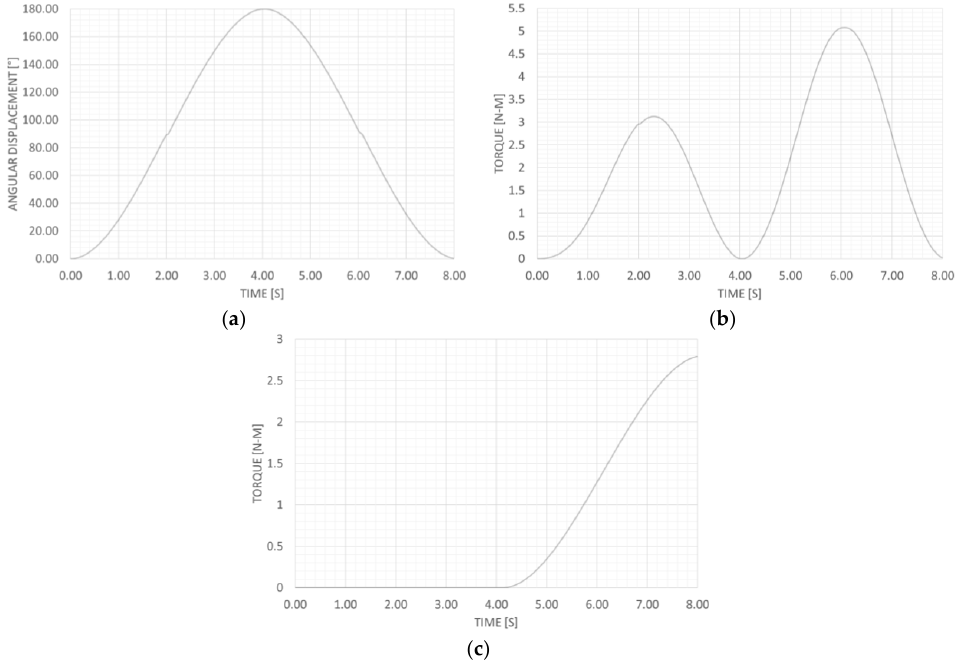
Figure 10. Simulation results for the Motor Unit simulation: ( a ) Angular displacement input, ( b ) Computed torque for shoulder motion, ( c ) Computed torque for arm motion.